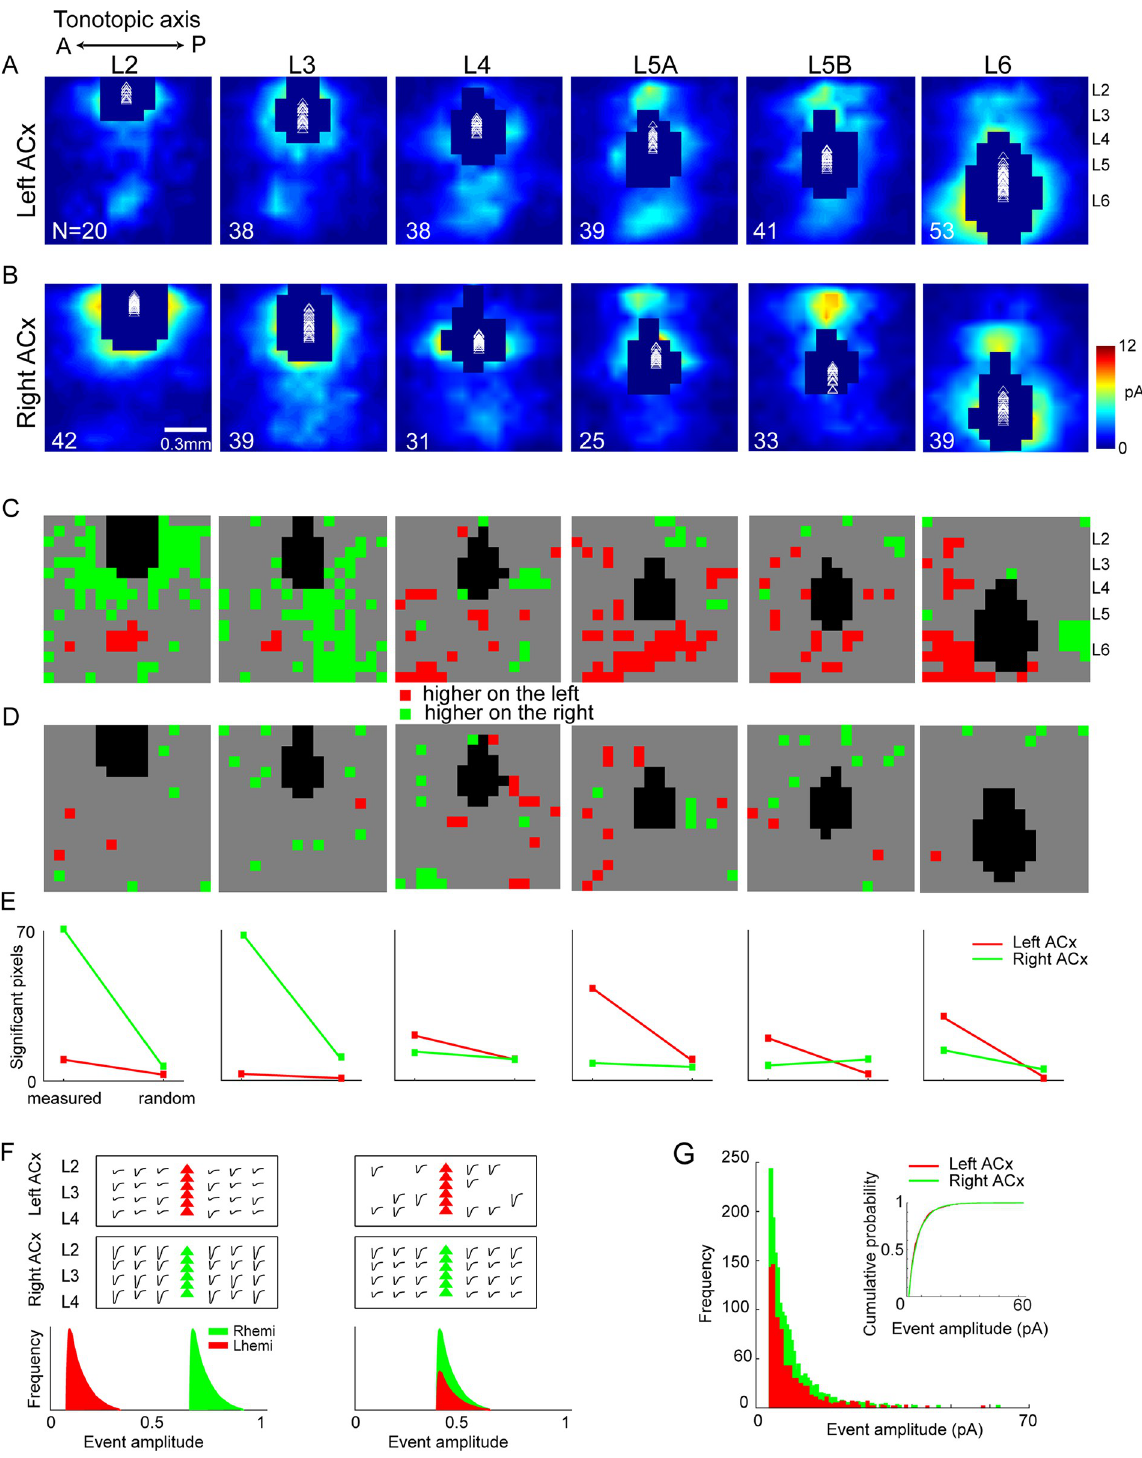
Fig 1. Summary of excitatory pathways in the left and right ACx across all cortical layers. AU : AbbreviationlistshavebeencompiledforthoseusedinFigs 1 to 4 : Pleaseverifythatallentriesarecorrect : (A, B) Patterns of excitatory synaptic input were recorded using LSPS as described in the text. Maps were averaged over all cells in each layer and then interpolated for clarity. Masked areas indicate direct hits in > 50% of cells for that region. White triangles denote location of somata. Laminar boundaries were defined with respect to the fractional distance from the L1/L2 boundary to the white matter. L5A and L5B were defined as the upper and lower 50% of L5, respectively. N indicates number of recorded cells for each panel. (C) Pixel-wise significance maps ( p < 0.05, unpaired 2-tailed t tests) for response